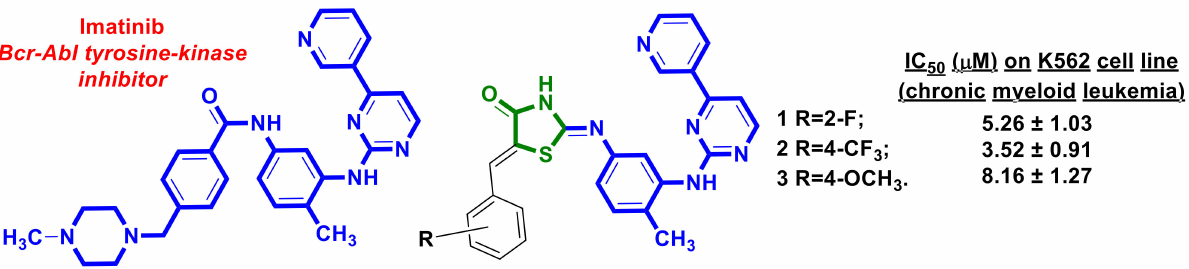
Figure 2. Structures of imatinib and 4-thiazolidinone-bearing imatinib analogs with anticancer activity.